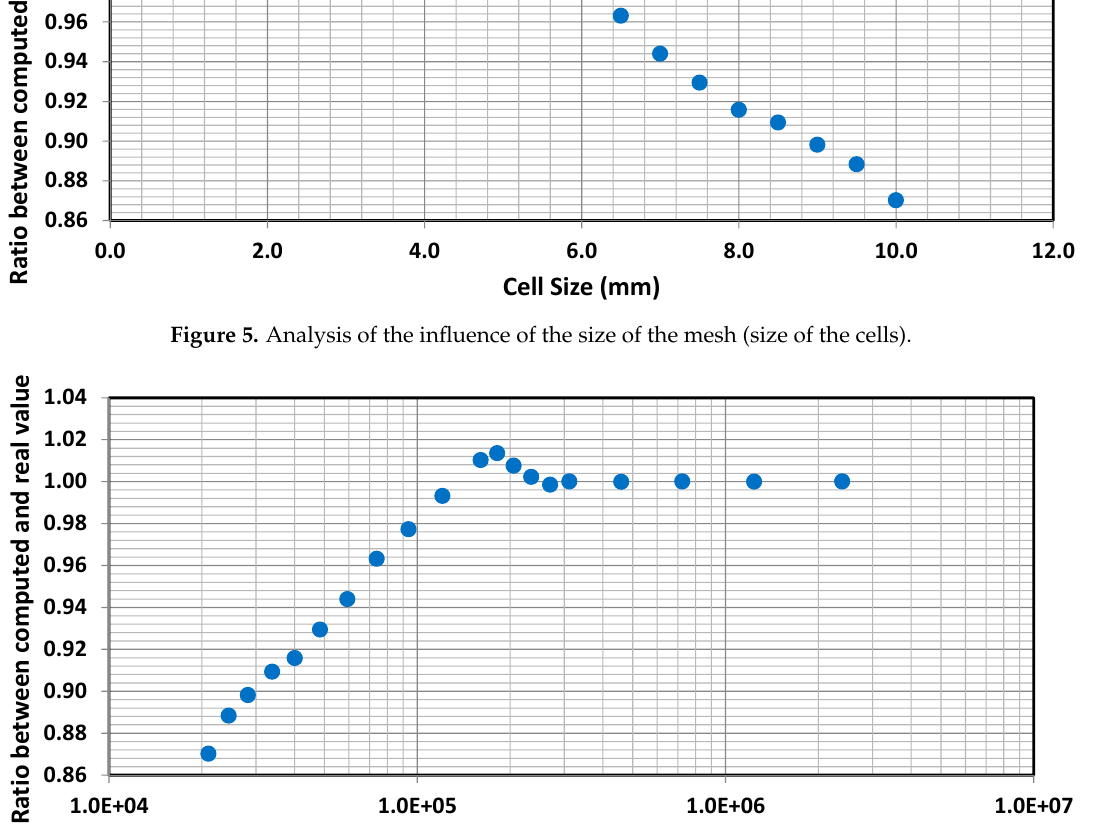
Figure 6. Analysis of the influence of the size of the mesh (number of cells).